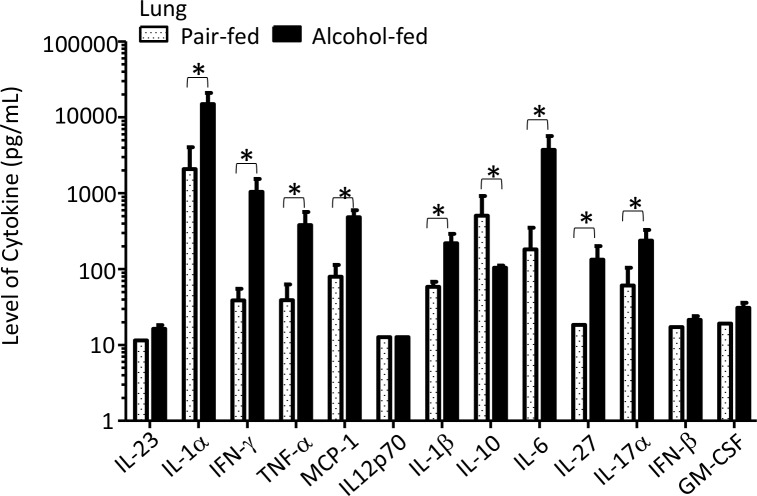
Binge-on-chronic alcohol use alters acute pulmonary inflammatory cytokines.Levels of pulmonary acute inflammatory cytokines were asssesed 48 hrs. post-Klebsiella infection via LEGENDplex 13-ples assay kit. Bars represent the mean cytokine level ± SEM, * indicates P < 0.05, by ANOVA with Dunn’s correction. N = 10/group.